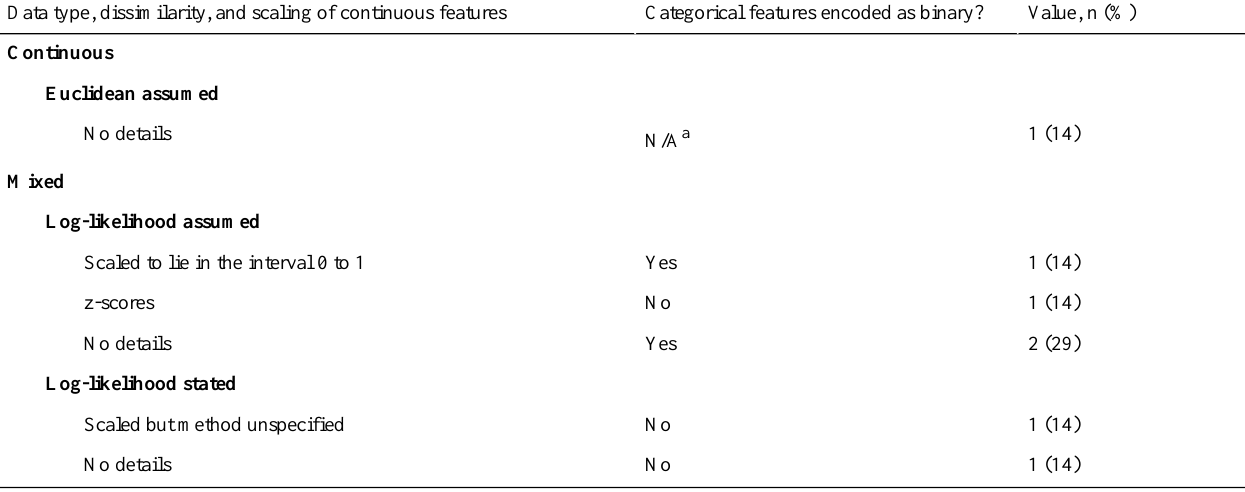
Table 4. Breakdown of methods used by studies applying SPSS TwoStep